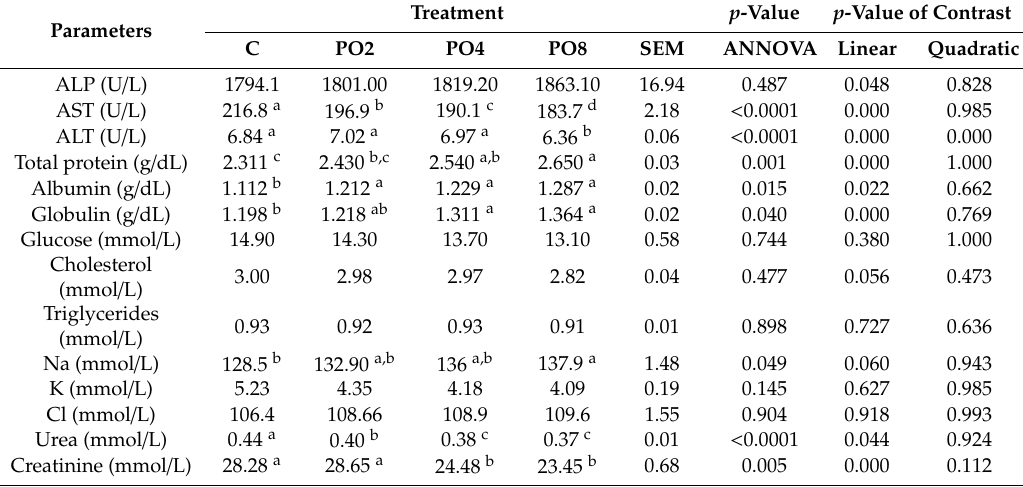
Table 5. Biochemical indicators of chicken blood from birds fed di ff erent supplementation doses of POLM at day 21.